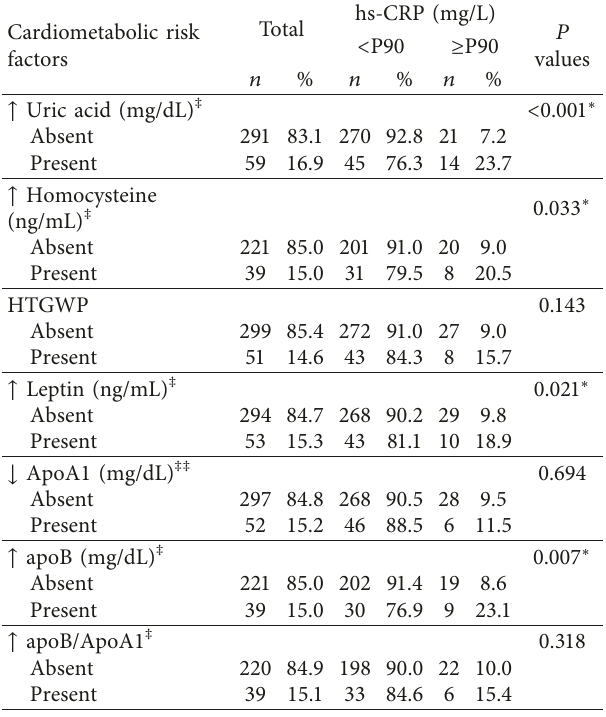
Table 2: Nontraditional cardiometabolic risk factors of children according to serum hs-CRP concentration, Viçosa, MG, Brazil,